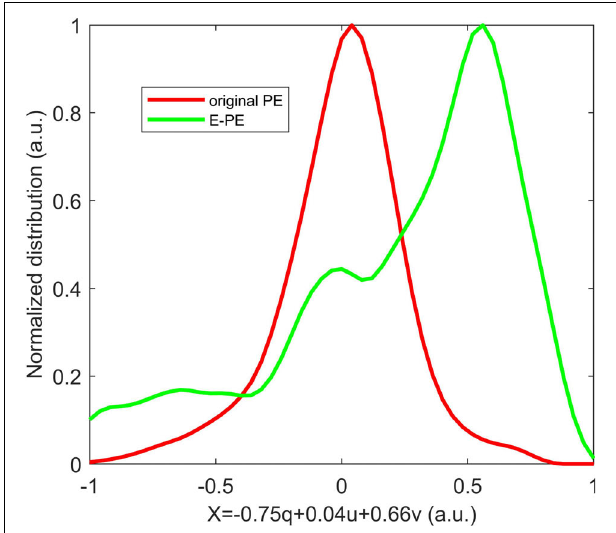
FIGURE 6 | Polyethylene (PE) before and after